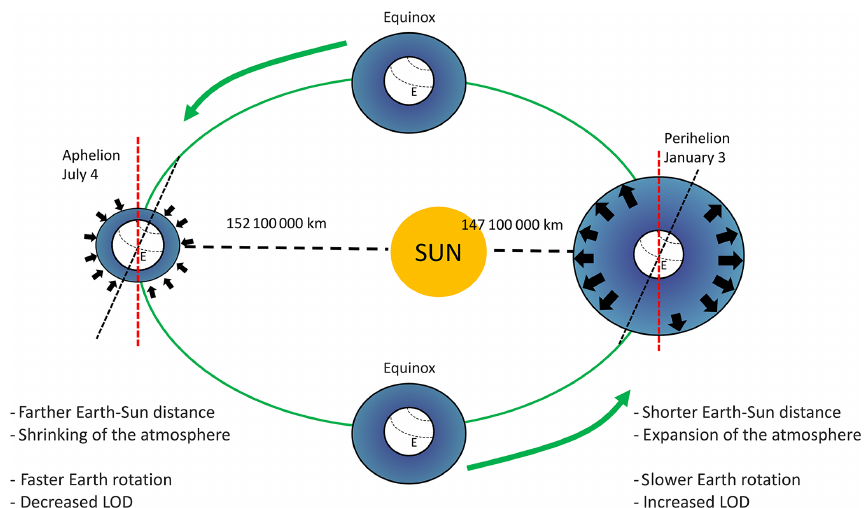
Figure 1. Schema of Earth and Sun correlation and the resulting effects on the thickness of the atmosphere and the Earth’s rotation